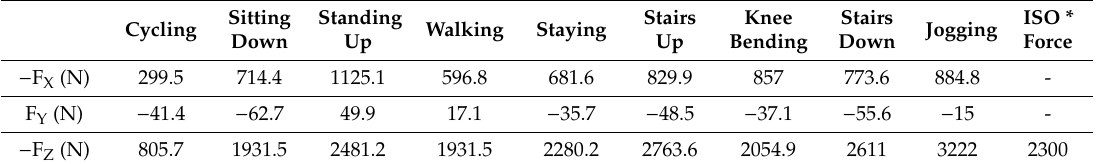
Table 4. Standardized loads for each of the daily activities considered for the study. * ISO 7206-4. Cycling